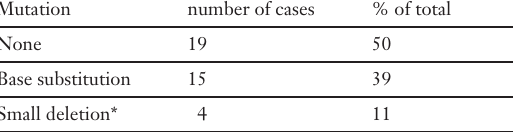
Type and frequency of mutations in 38 Swiss patients with primary breast and ovarian cancer.